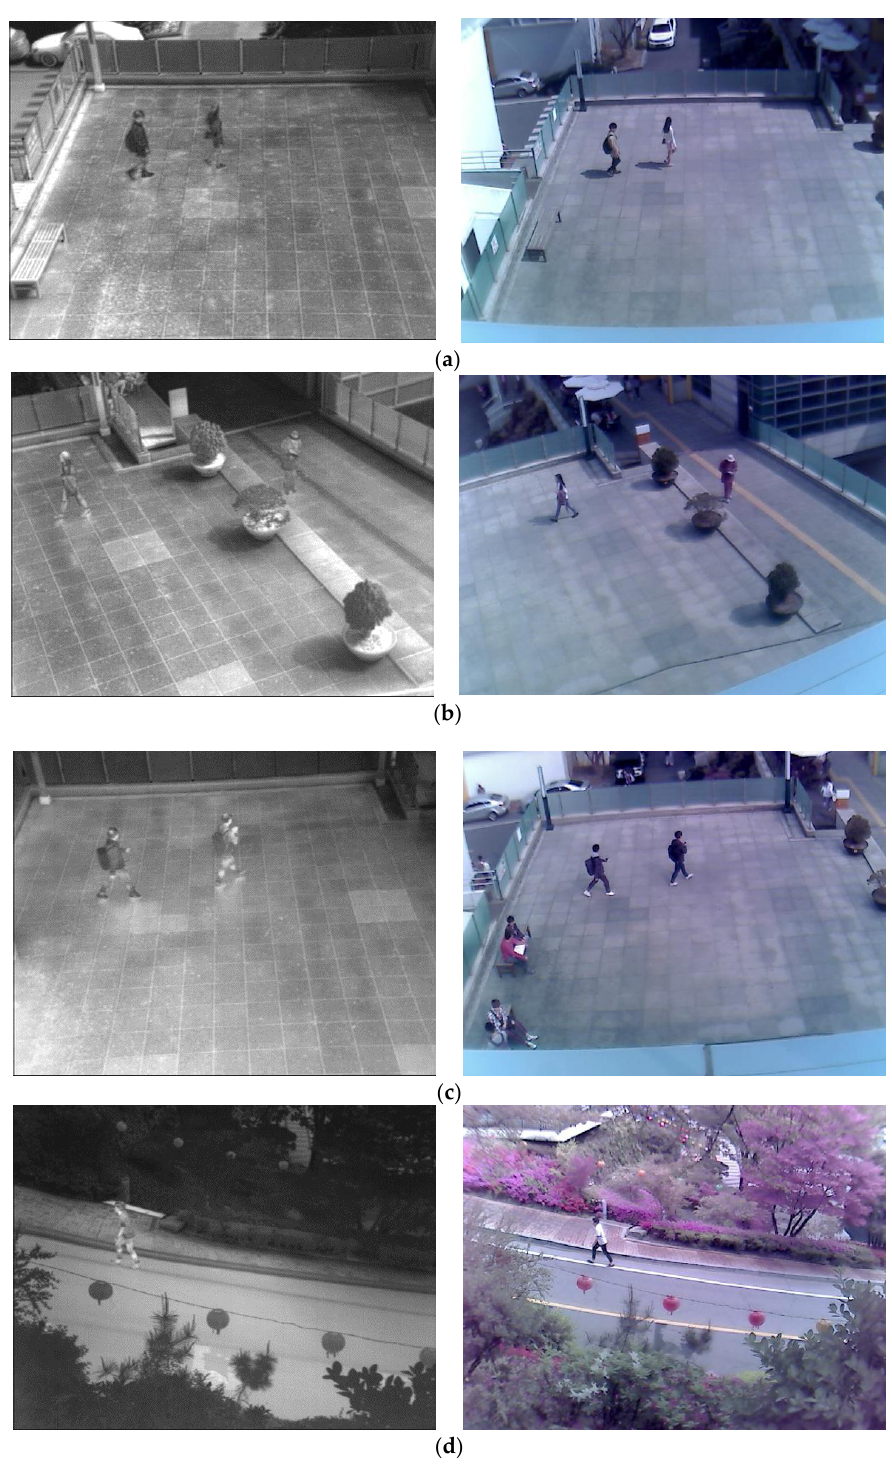
Figure 8. Example of various images in the experimental DVLFPD-DB1 used in this study: ( a ) Sub-database 1, ( b ) Sub-database 2, ( c ) Sub-database 3, and ( d ) Sub-database 4.